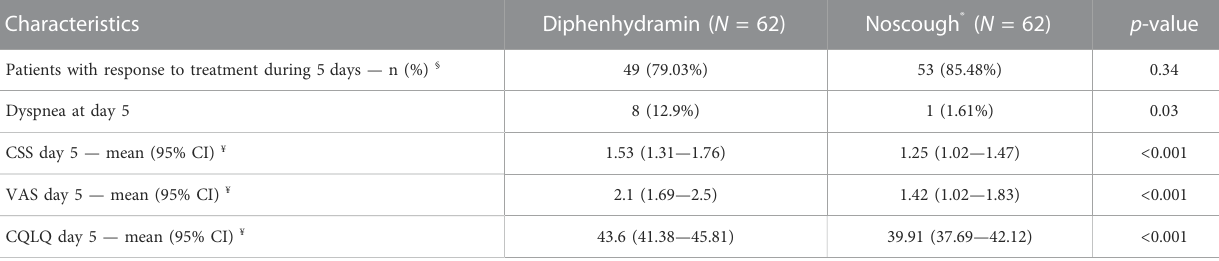
TABLE 2 Results of the primary and secondary outcomes.